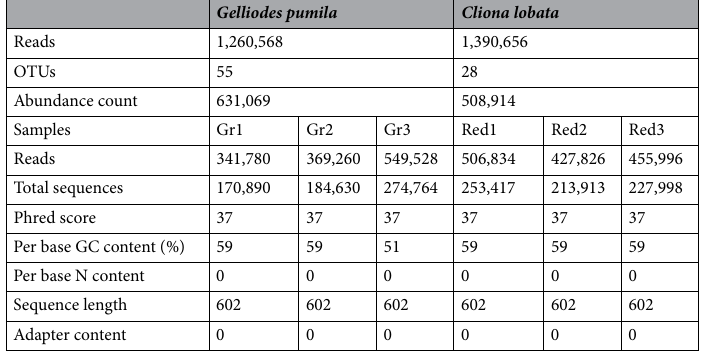
Table 1. Sequence reads and QC